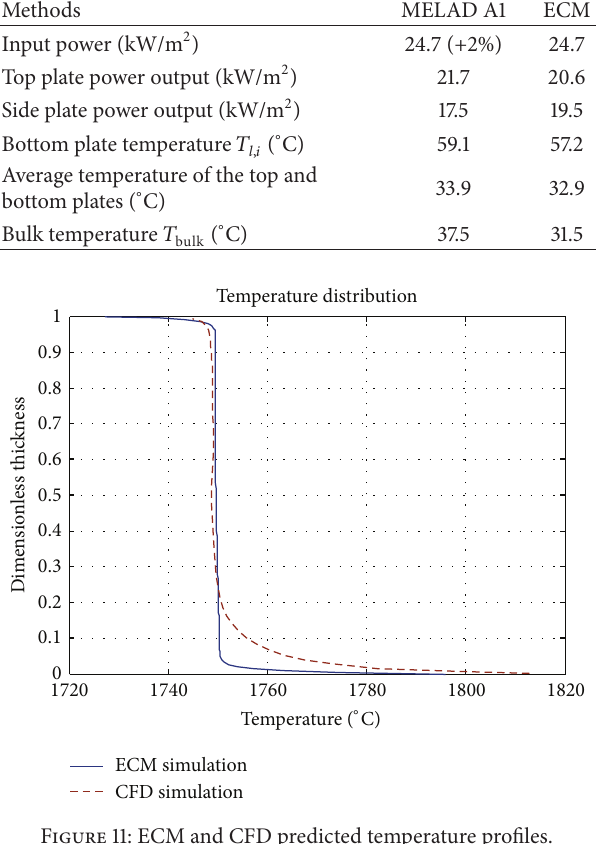
Figure 11: ECM and CFD predicted temperature